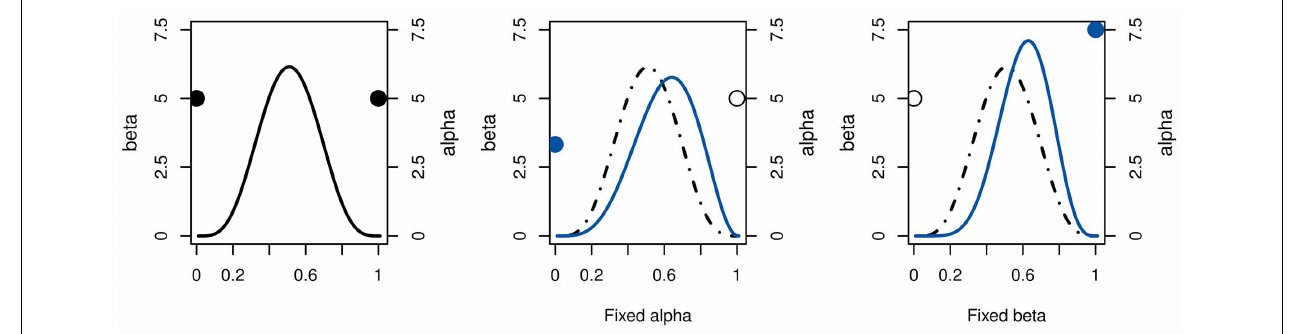
FIGURE 1 | Illustration of the relationship between Beta parameters for a given positive mean shift of an arbitrary distribution (left). If α is fixed ( middle ), the lower β results in a flatter distribution